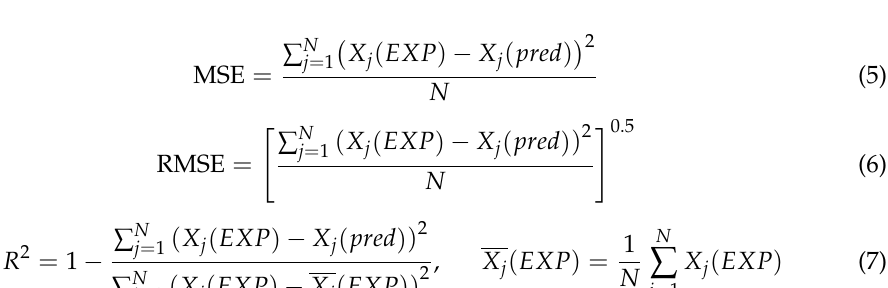
Figure 5. Implemented network structure.